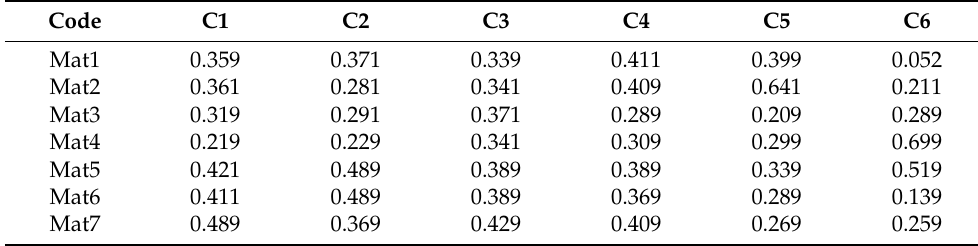
Table 16. Normalized PROMETHEE II